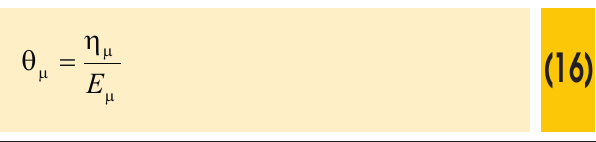
Figure 4 – Creep function J for t'=2.8